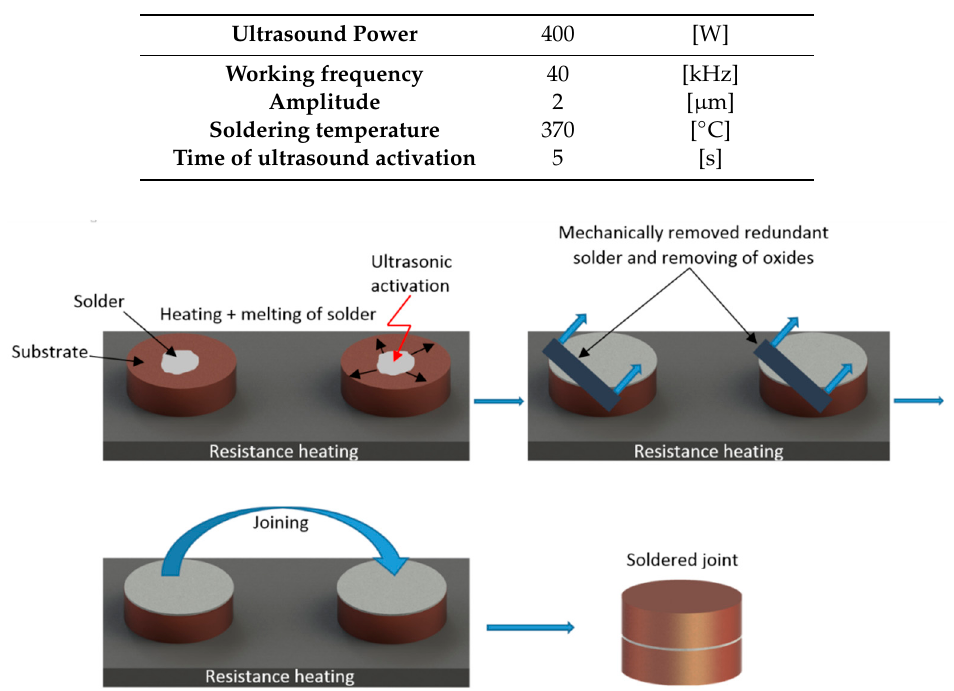
Figure 3. Schematic representation of the soldering process with ultrasound assistance.